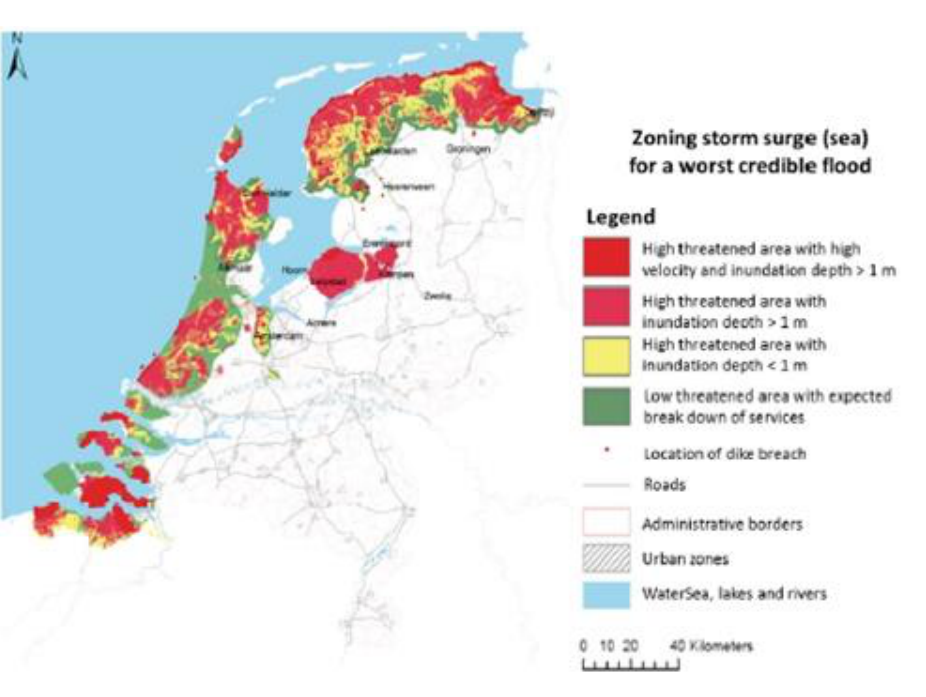
Figure 2. Map of the areas with the worst credible floods in the Netherlands (Source: [53]).